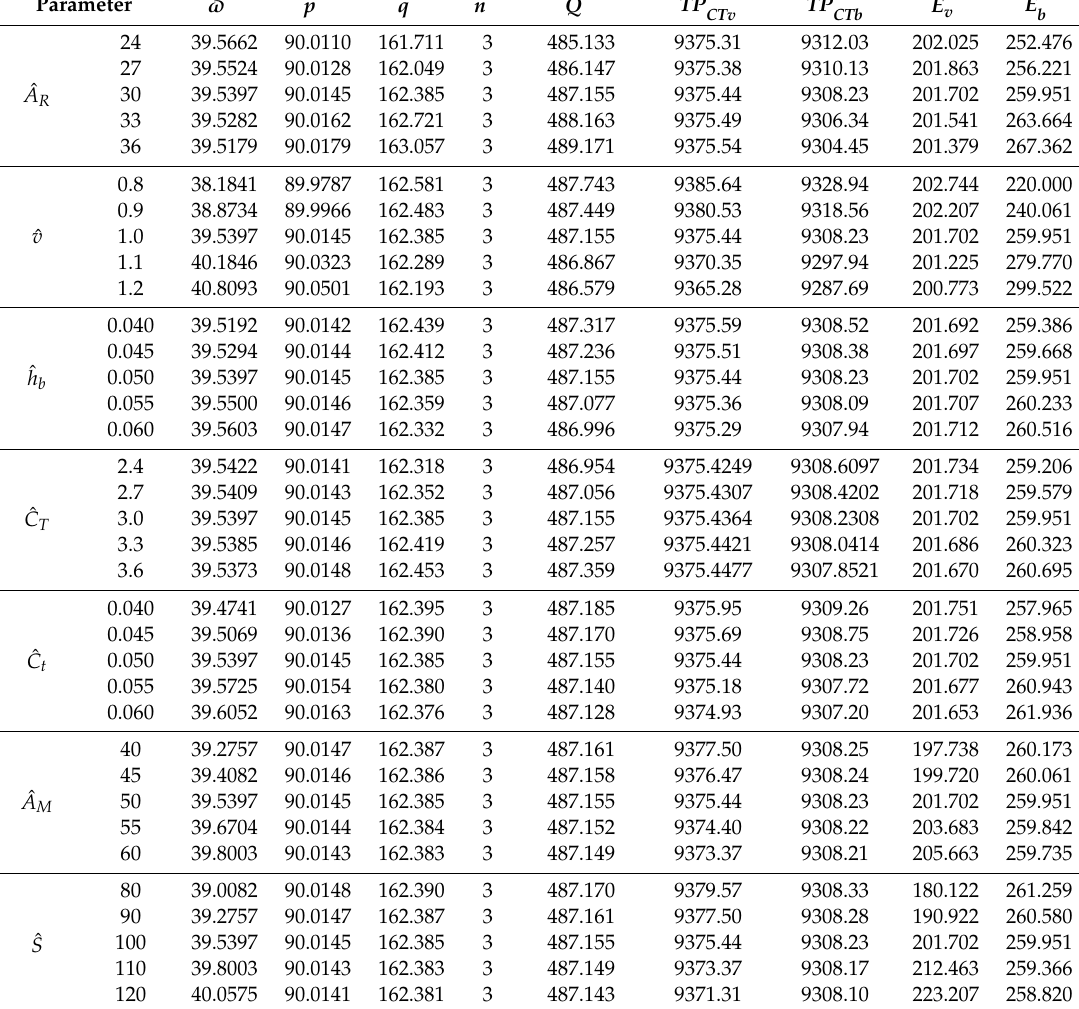
Table 3. Impacts of carbon emission parameters on the optimal equilibrium